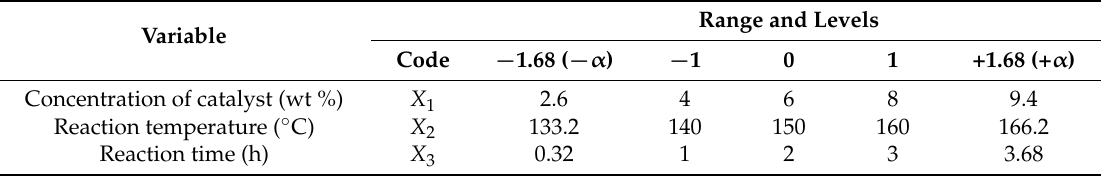
Table 4. Experimental range and levels coded of independent